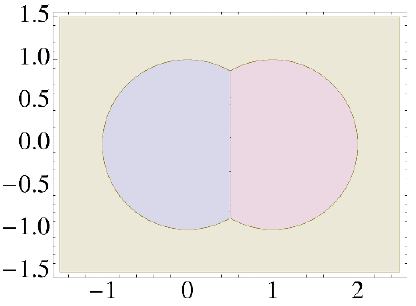
Figure 1. Once we send our four points to (0 , z, 1 , and yellow z -plane regions respectively. We have used a change of variables to give all integrals the blue domain, which we denote by